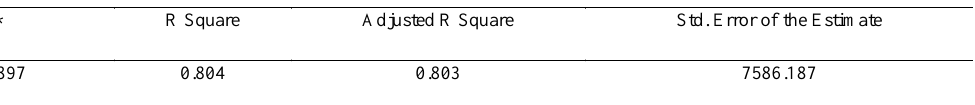
Table 2: Summary of the model